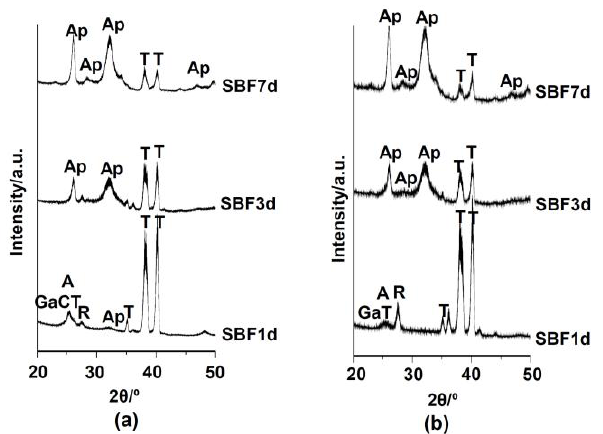
Figure 8. TF-XRD profiles of the Ti surfaces soaked in SBF for different days after ( a ) 100Ca + 0.05Ga, heat and water or ( b ) 100Ga, heat and water treatments following the NaOH treatment. T: α-Ti Ap: Apatite A: Anatase R: Rutile, Ga-CT: Ga x Ca 1−1.5 x Ti 4 O 9 , Ga x Ca 1−1.5 x Ti 2 O 4 , Ga x Ca 1−1.5 x Ti 4 O 5 , GT: Ga 2 TiO 5 .